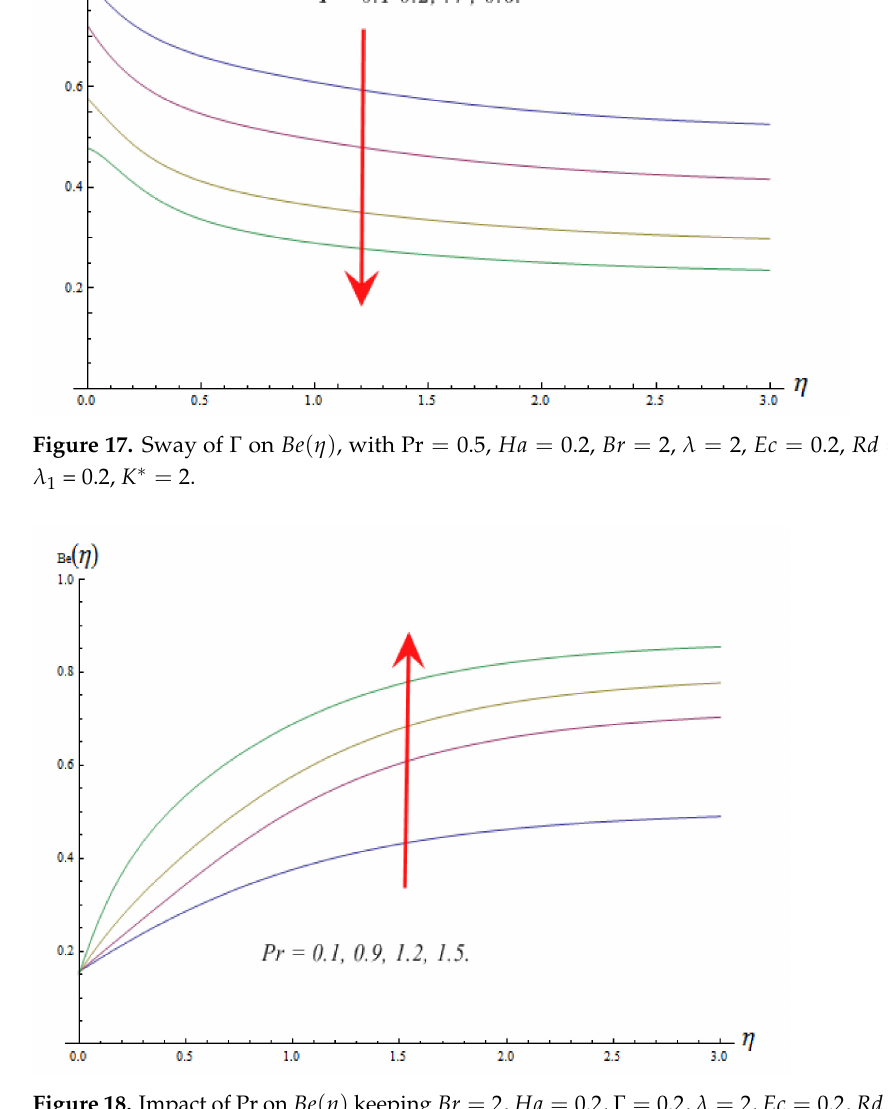
Figure 18. Impact of Pr on Be ( η ) keeping Br = 2, Ha = 0.2, Γ = 0.2, λ = 2, Ec = 0.2, Rd = 2, β 1 = 0.2, λ 1 = 0.2, K ∗ =